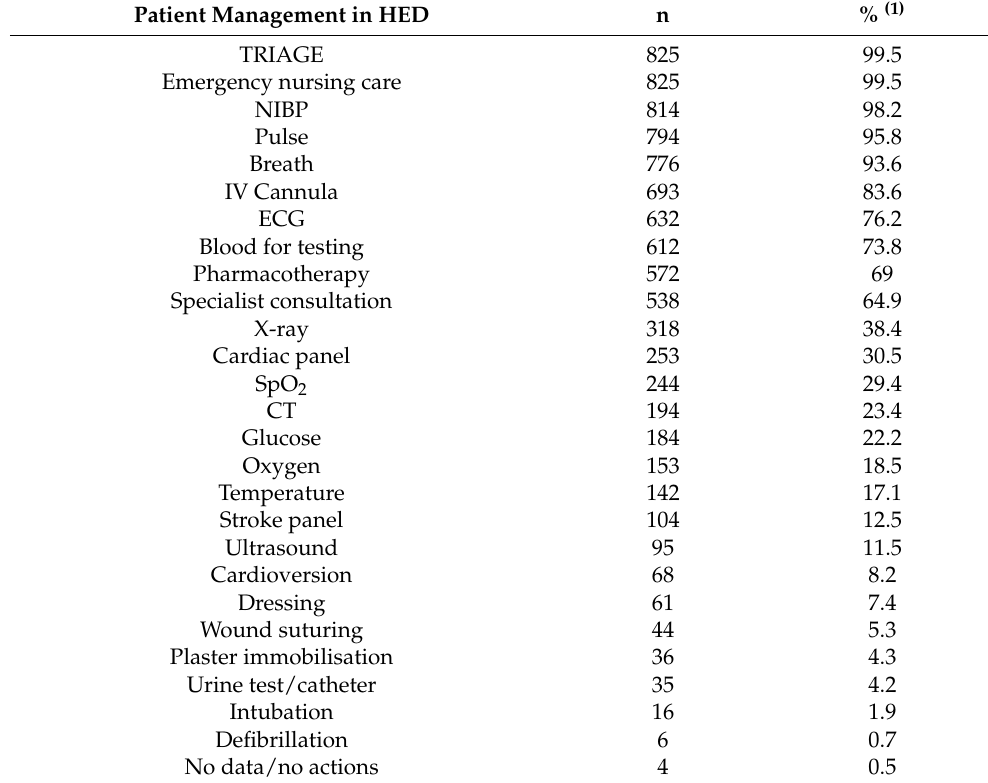
Table 8. Emergency procedures performed in